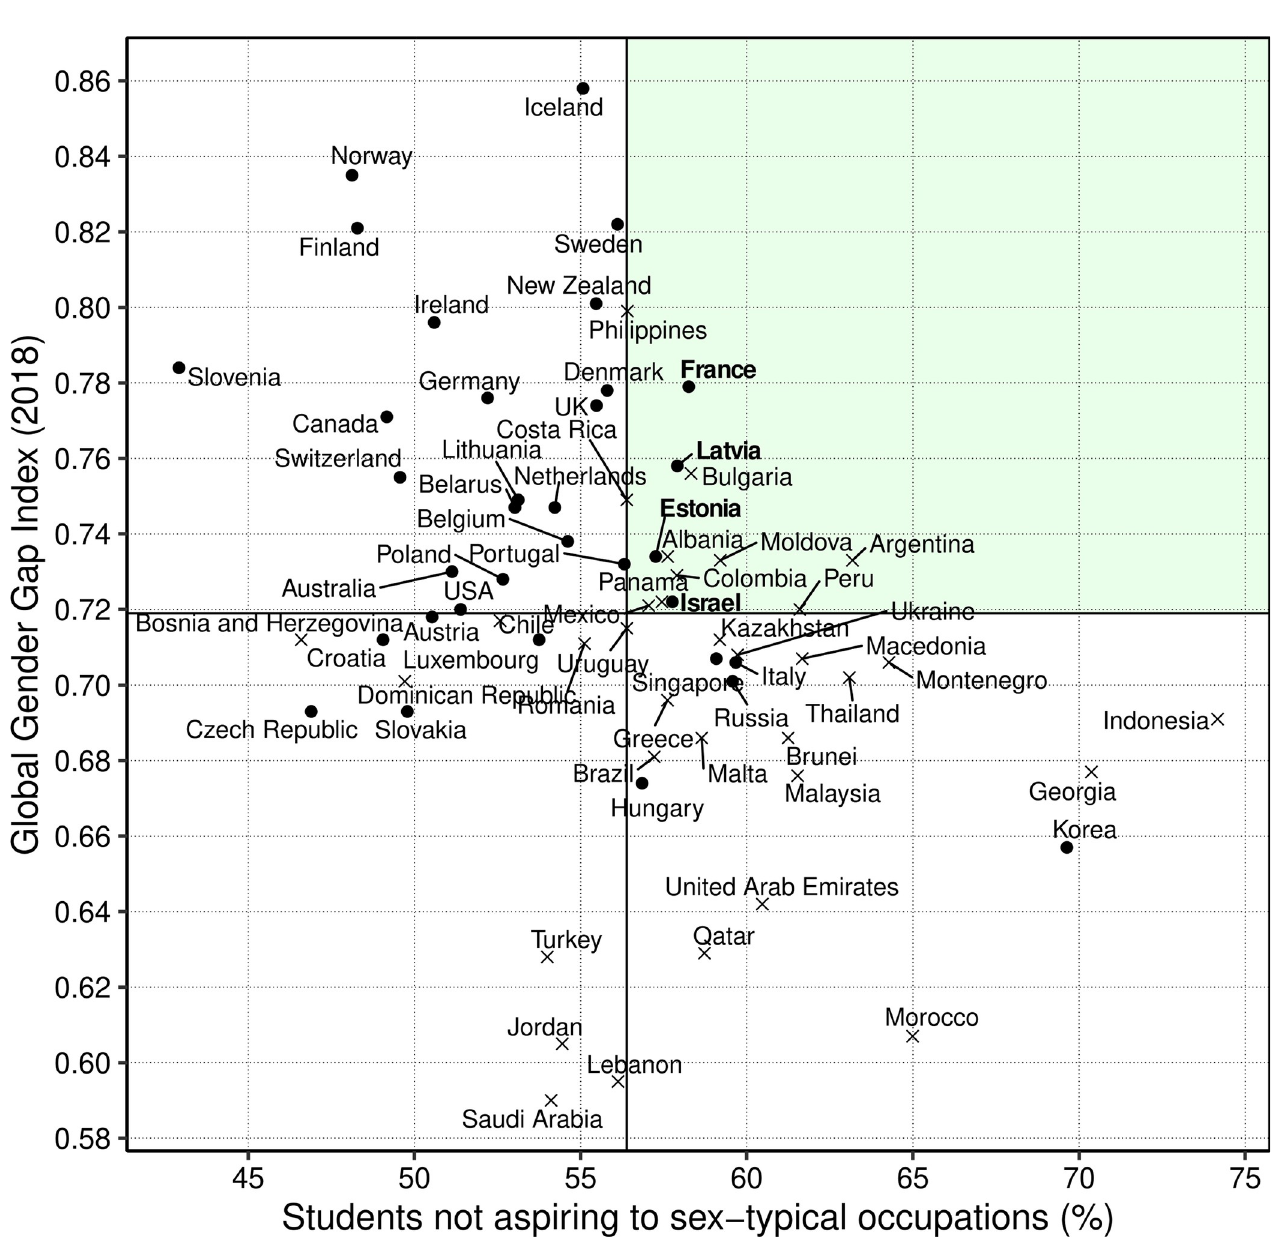
Fig 4. Countries that stand out in increasing the percentage of students not aspiring to sex-typical occupations with above average levels of women’s empowerment and educational achievement. Note that four (of 69) countries met these criteria, namely France, Latvia, Estonia, and Israel. The other countries in the green area had below average levels of educational